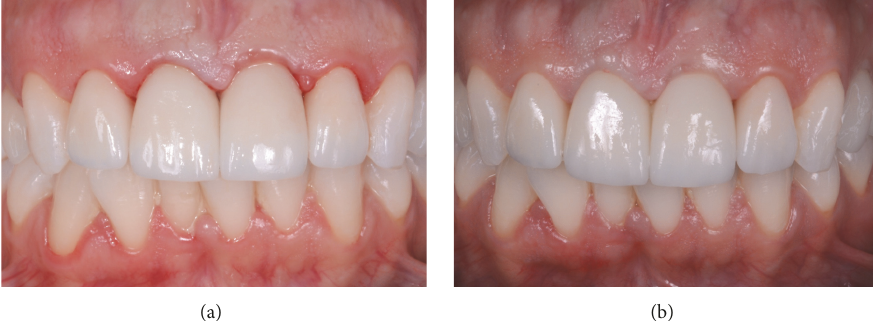
Figure 7: The definitive ceramic restoration in position. (a) The definitive ceramic crown is delivered to the patient, along with the other planned definitive, tooth-supported restorations. (b) The aesthetic result 4 months after implant placement.